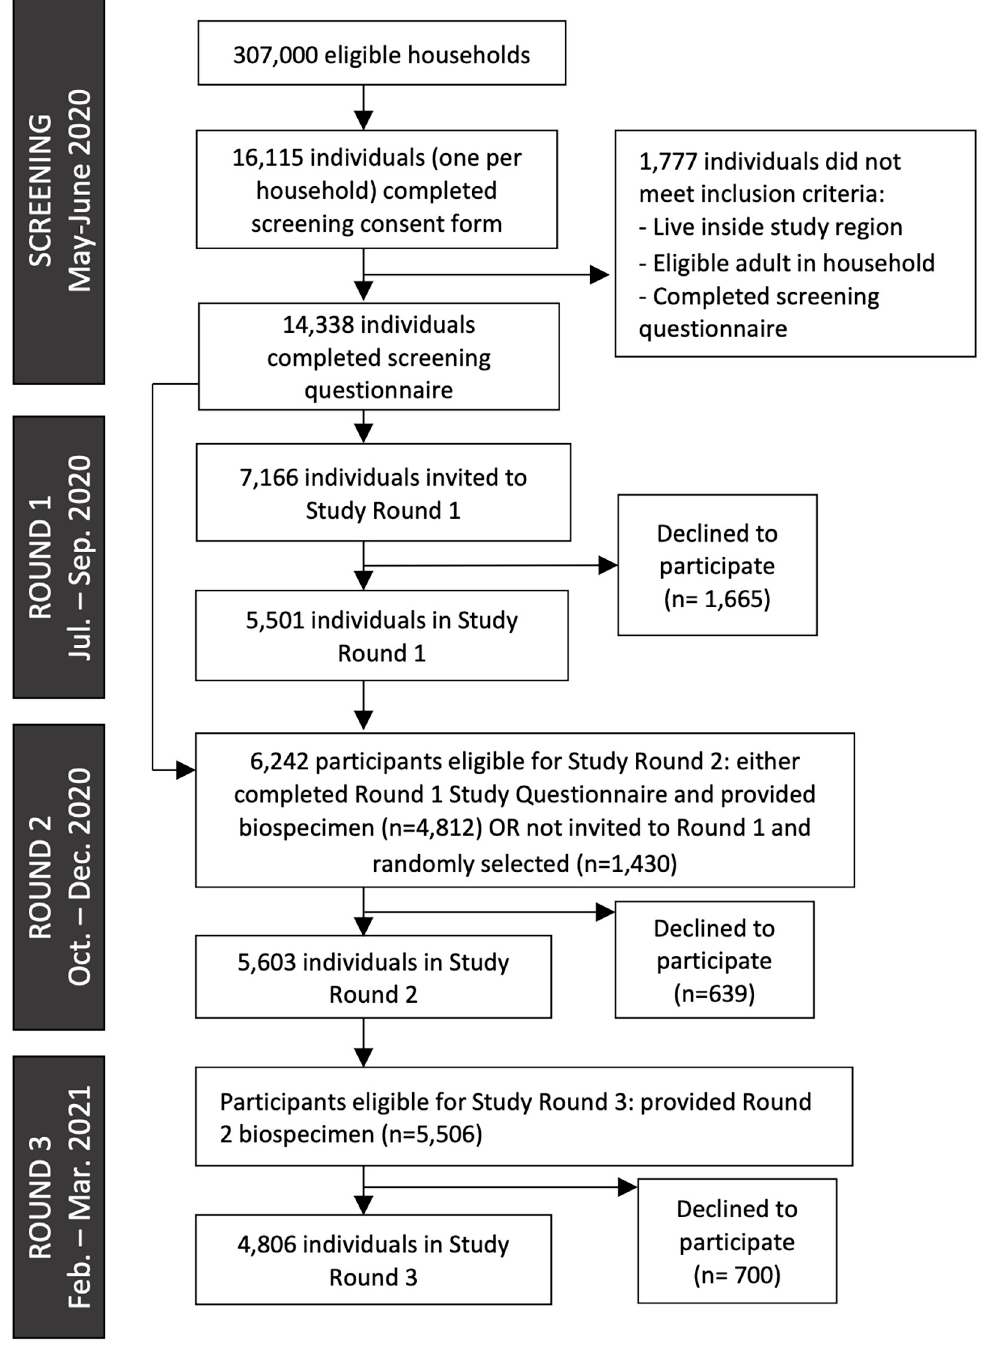
Fig 1. Study flow